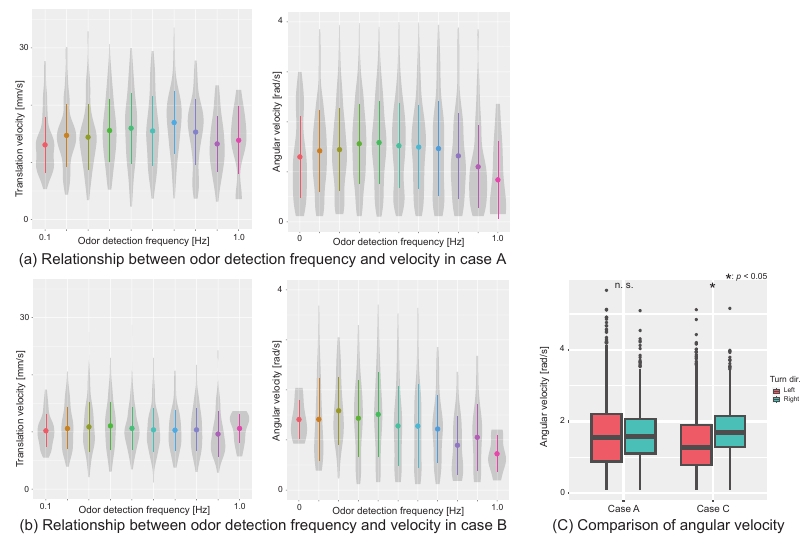
Figure 2. Analysis of a silk moth velocity change in VR experiments. ( a ) Odor detection frequency and changes in translation and angular velocity in Case A. ( b ) Odor detection frequency and changes in translation and angular velocity in Case B. ( c ) Effect of angular velocity on visual stimulus